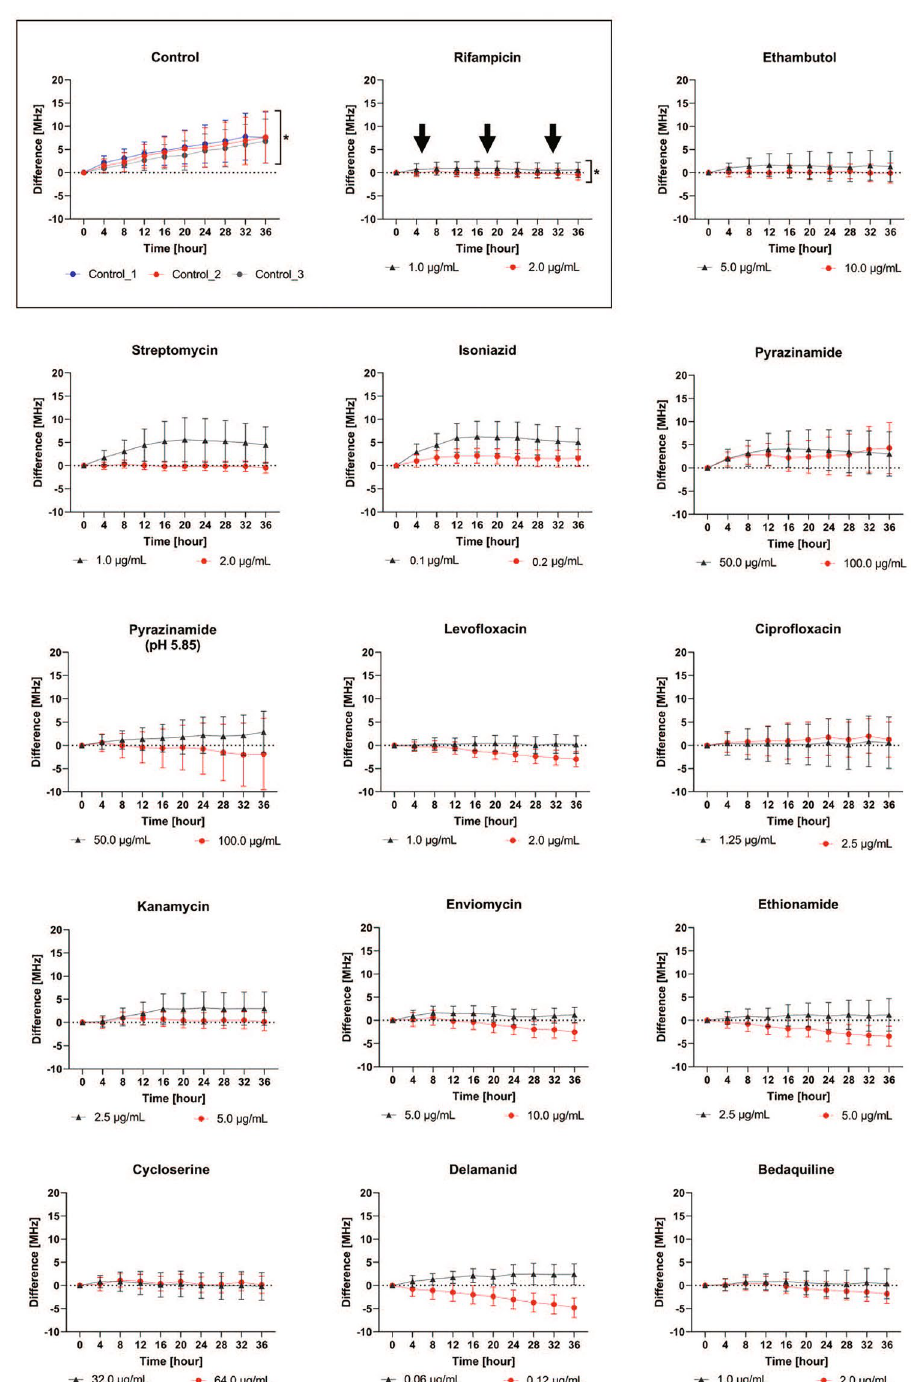
Figure 3. Comprehensive drug susceptibility testing using the sensor. BCG was cultured on the sensor, and then one of two different concentrations of first-line or second-line anti-TB drugs were injected into each culture. The mean difference in resonance frequency of all evaluable elements (MHz) is shown for the cultures treated with the low concentration (black triangle) or high concentration (red circle). The error bars show the standard deviation (SD) of the element measurements. As shown in the upper left rectangle, the mean difference and SD increased over time (*) in the control, but no apparent changes in these factors were observed following RFP administration ( ↓ , *). RFP, EB, SM, INH, LVFX, KM, EVM, TH, CS, DLM, and BDQ each had an antibacterial effect against BCG when used at the high concentration dose. PZA and ciprofloxacin also caused a large SD and did not show any obvious antibacterial activity against BCG. For LVFX, EVM, TH, DLM, and BDQ, the resonance frequency change (MHz) was negative, and the SD was small for the high-concentration dose. The time required for stable drug efficacy was a maximum of 16 h, which is nearly the length of the BCG growth cycle. SD standard deviation,